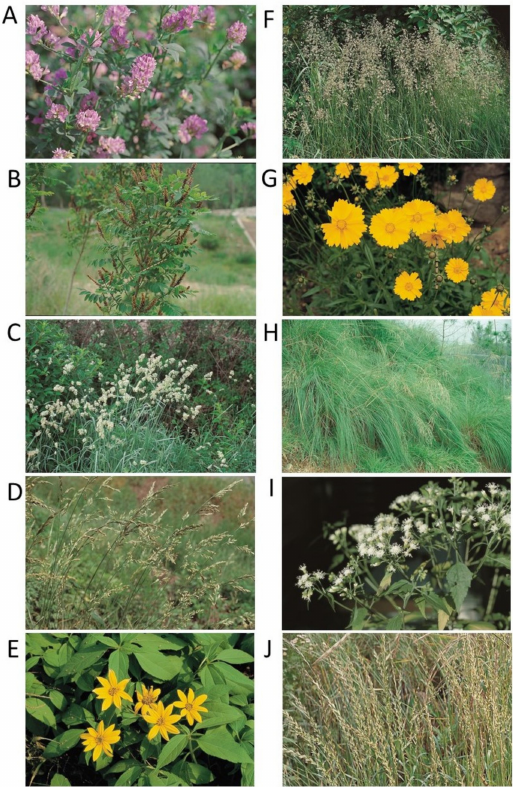
Figure 2. Photographs of ten introduced alien plant species in South Korea. ( A ) Medicago sativa ; ( B ) Amorpha fruticose ; ( C ) Dactylis glomerate ; ( D ) Festuca arundinacea ; ( E ) Helianthus tuberosus ; ( F ) Poa pratensis ; ( G ) Coreopsis lanceolate ; ( H ) Eragrostis curvula ; ( I ) Ageratina altissima ; and ( J ) Lolium perenne